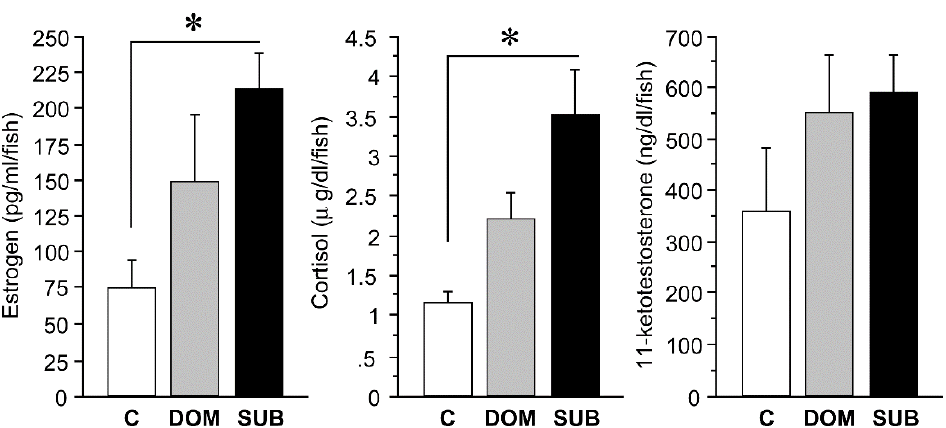
Figure 1. Histograms showing plasma hormone (estrogen, cortisol and 11-ketotestosterone) levels in control (C), dominant (DOM) and subordinate (SUB) males. * p < 0.05 significantly different when compared with control.